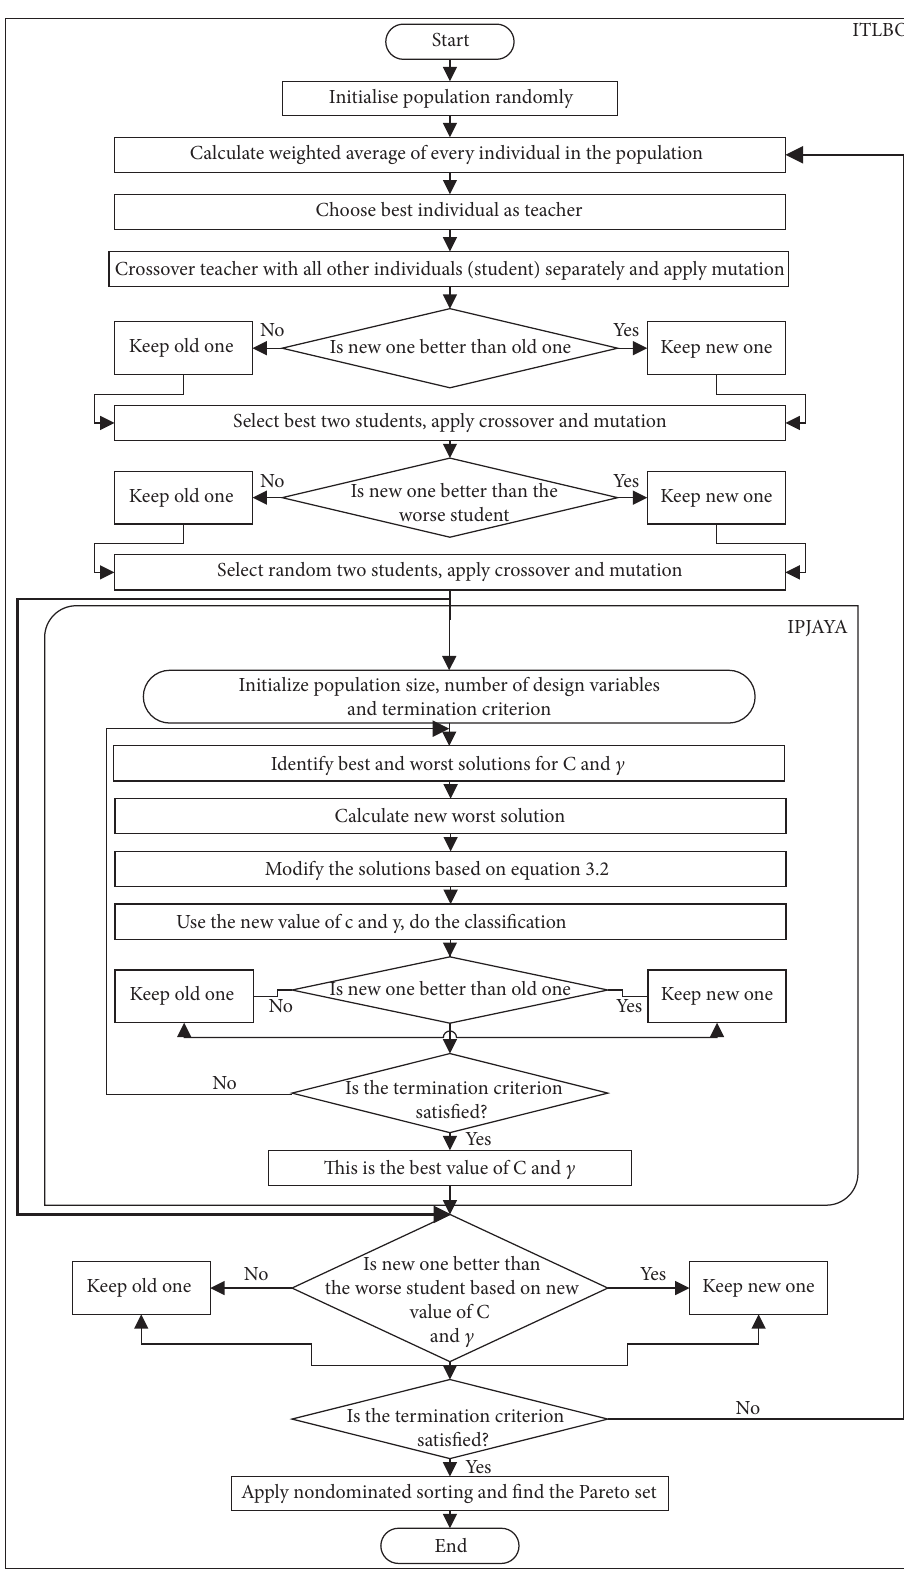
Figure 11: Details of the proposed